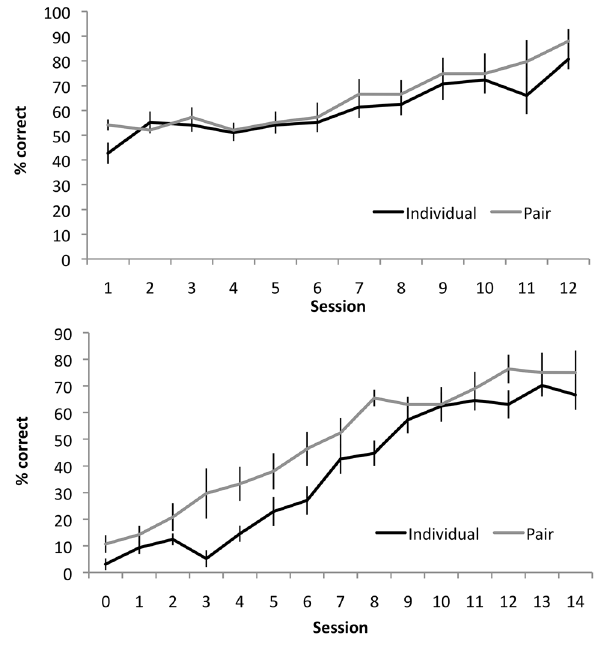
Figure 2. Mean 6 SE correct responses for individual and paired calves during (a) the initial colour discrimination task, and (b) the reversal task. Individual ( n =8) and paired calves ( n =8) performed similarly in the initial discrimination task, but individual calves had significantly lower number of correct choices throughout the reversal learning task ( p =0.018) compared to paired calves ( n =7). Testing ended once calves reached the learning criterion of 80% correct over two sessions. The first calf reached criterion at session 11 of reversal; after 14 sessions, 4 calves had reached the criterion. For sessions 12 to 14 the averages displayed were calculated using the calves still undergoing testing and the mean performance the last two complete sessions of calves that had reached the criterion and were no longer being tested.